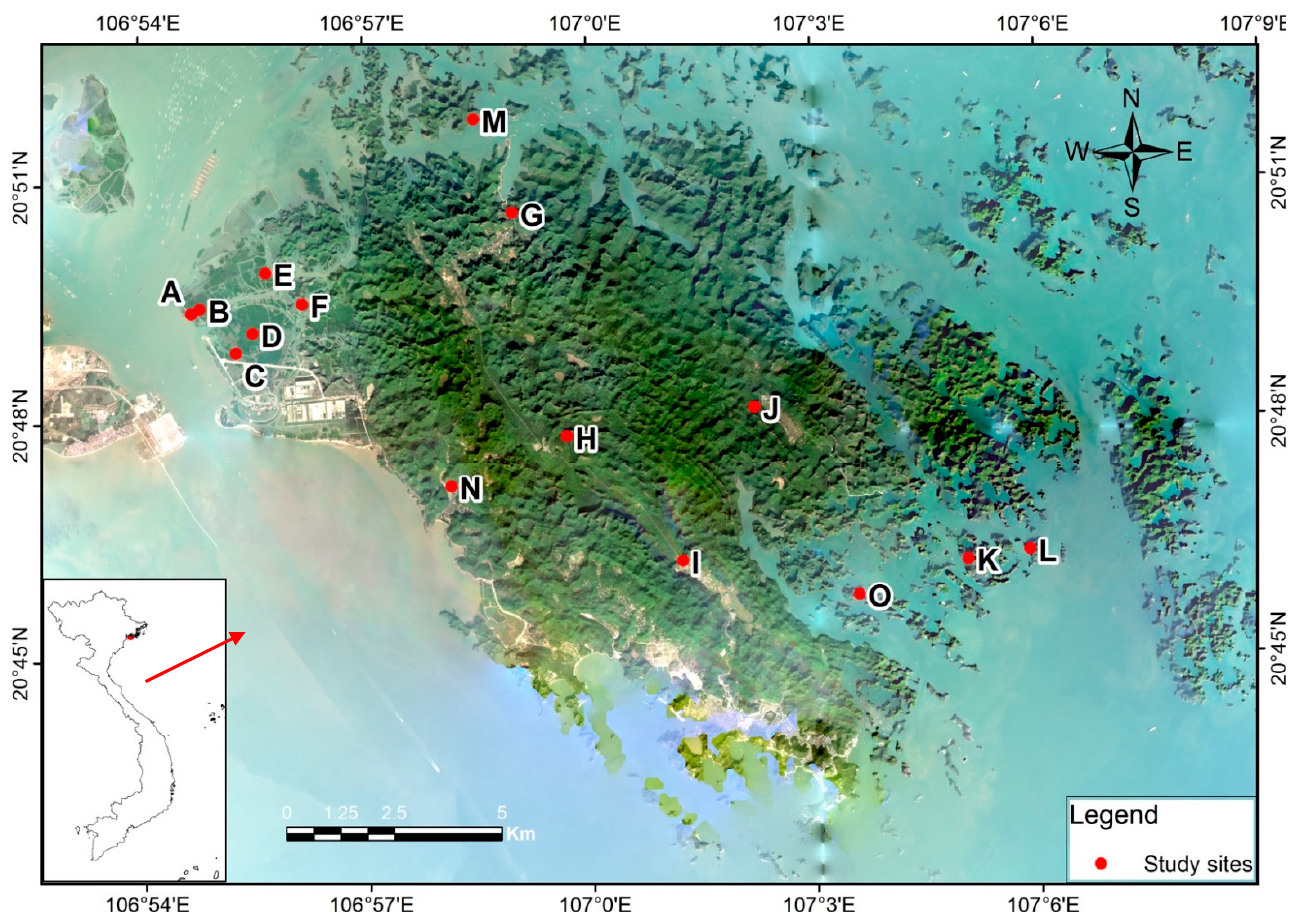
Figure 1. Map of Cat Ba Biosphere Reserve. The solid red dots and capital letters represent the study sites between 2015 and 2020. The local name and geographical coordinate of each site are given in Table 1. Background map was obtained from the “Satellite imagery: Planet Labs Inc. (San Francisco, CA,